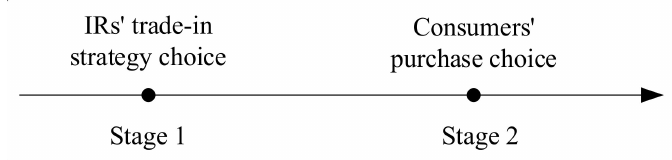
Figure 1. Game sequence of IRs and consumers.